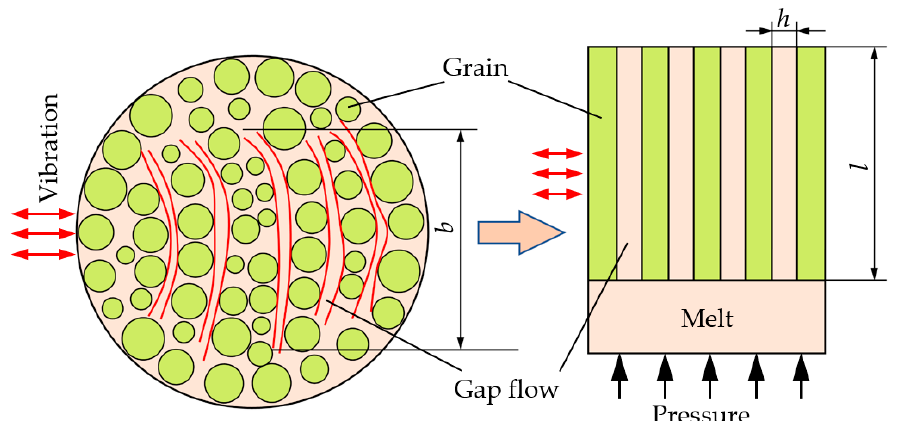
Figure 14. Simplification of transforming the complicated interdendritic feeding under vibration into a simple gap flow of parallel plates. a simple gap flow of parallel